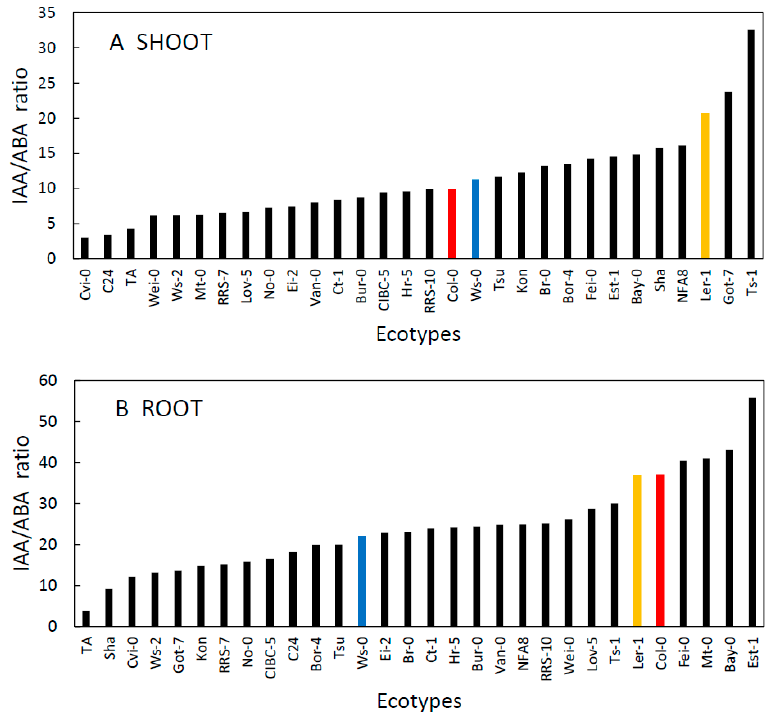
Figure 4. The ratio of IAA to ABA content in the shoot ( A ) and root ( B ) ranked from the lowest to the highest among thirty A. thaliana ecotypes grown 21d in controlled conditions. Commonly used ecotypes are marked in colour (Red = Col-0, Blue = Ws-0, Orange = Ler-1). See Table 1 for the full list of ecotypes.